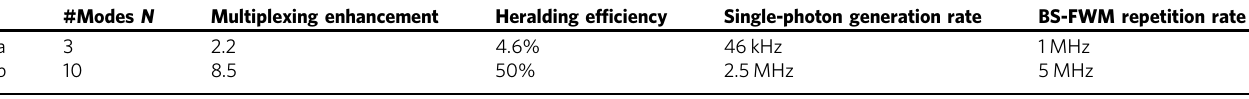
Table 1 Performance of the frequency multiplexed